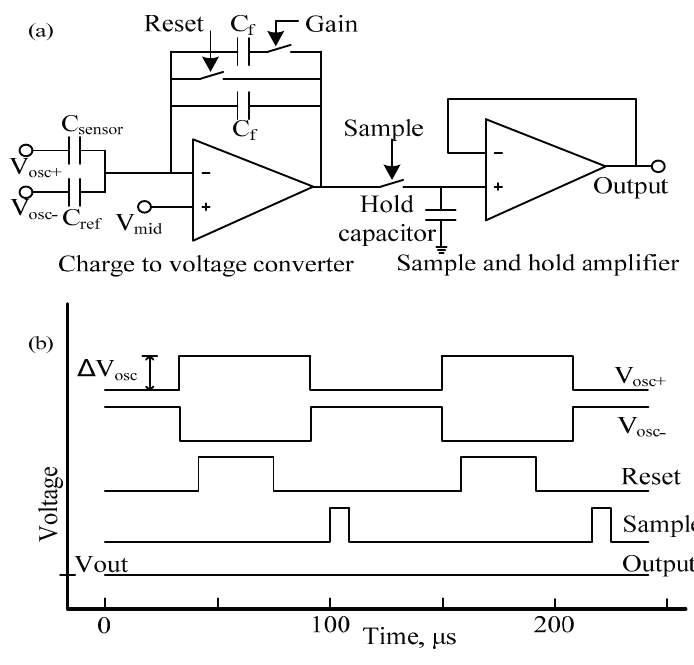
Figure 1. ( a ) Schematic diagram of the Complementary Metal-Oxide Semiconductor (CMOS) sensor interface circuit; ( b ) Waveforms of the control and output signals for the CMOS